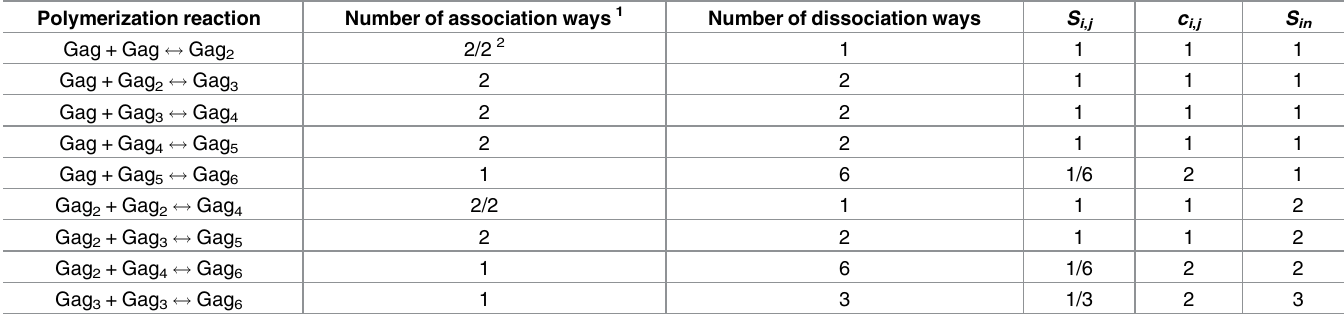
Table 2. Polymerization reactions and statistical factors.